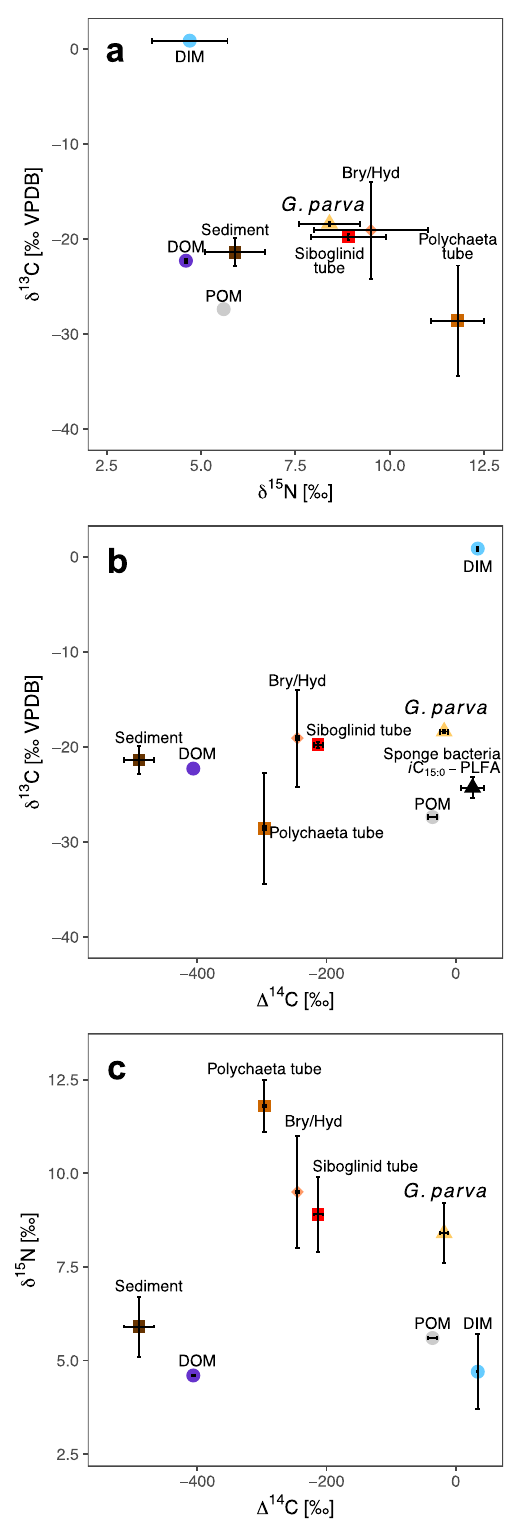
sponge specimen, tissue age increased with radial distance from sponge center; the outer layer (below the cortex) and inner sections of tissue (separated by 9 cm) differed by 163 a, indicating a growth rate of 0.55 mm per year. Thus, we conclude an average sponge age of ca. 300 years for the average adult sponges of the Langseth Ridge seamount community. The ages of all material collected from and comprising the underlying mats, i.e., siboglinid and calcareous